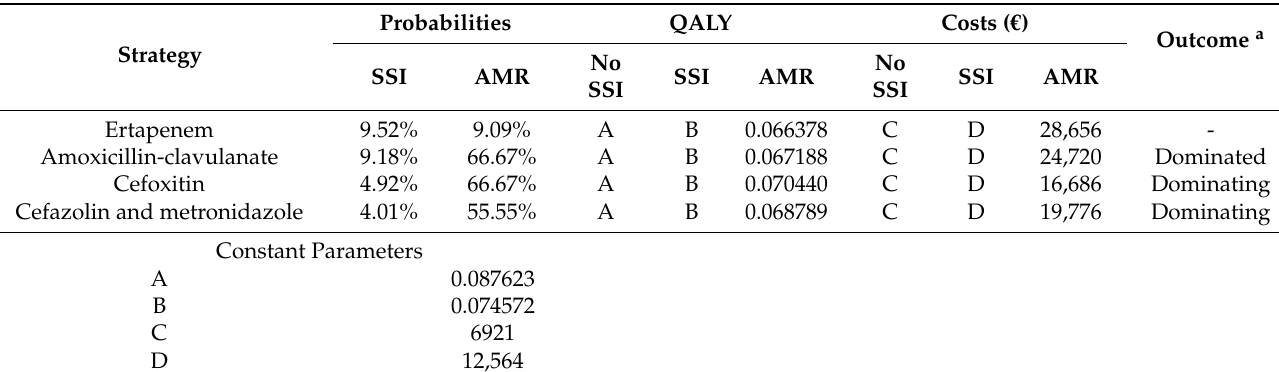
Table 1. Input parameters and results of the cost-effectiveness analysis comparing ertapenem to standard prophylactic regimens for elective colorectal surgery.